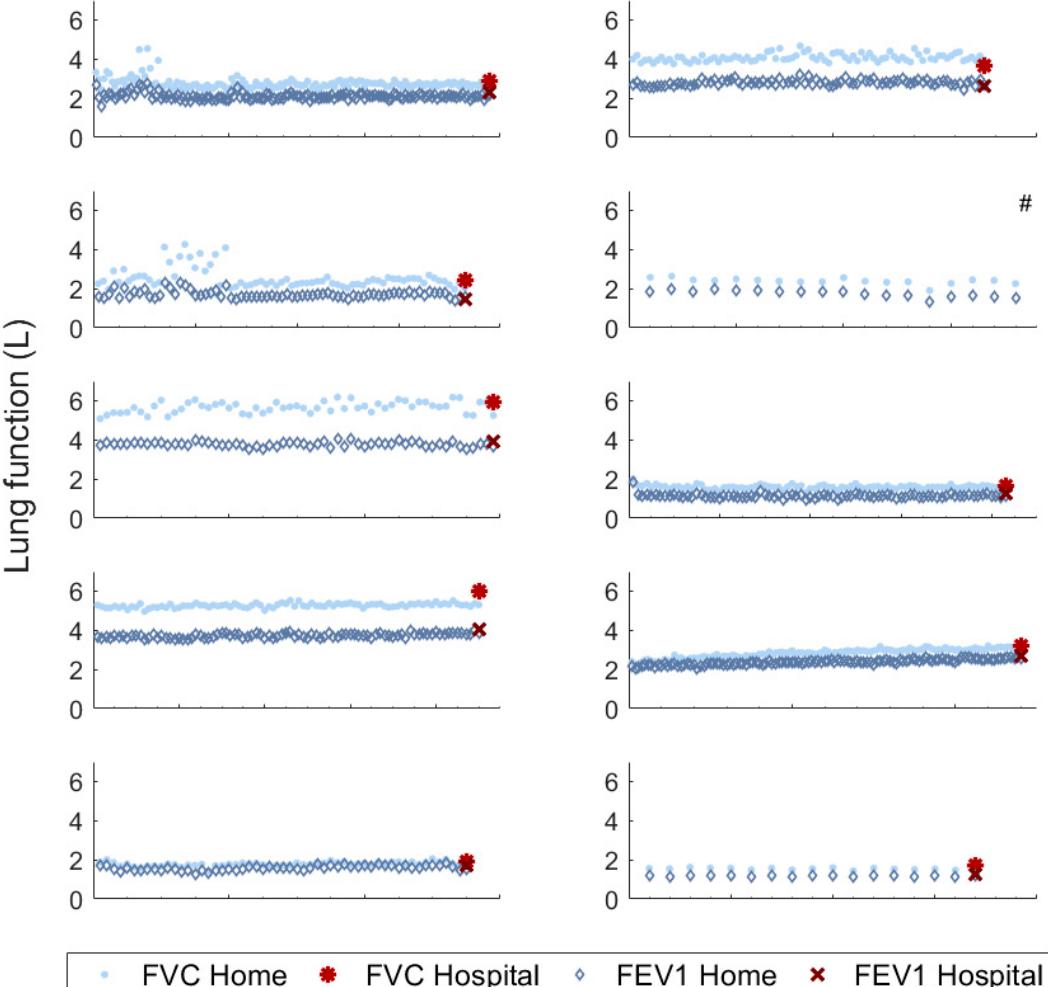
Figure 1. Home and hospital spirometry for all subjects during the study. #: patient did not finish the study due to hospitalization. X-axis represents individual spirometry measurements. Median follow-up in the study was 93 (IQR, 76–130) days. FVC: forced vital capacity, FEV1: forced expiratory volume in 1 s, IQR: inter quartile range.